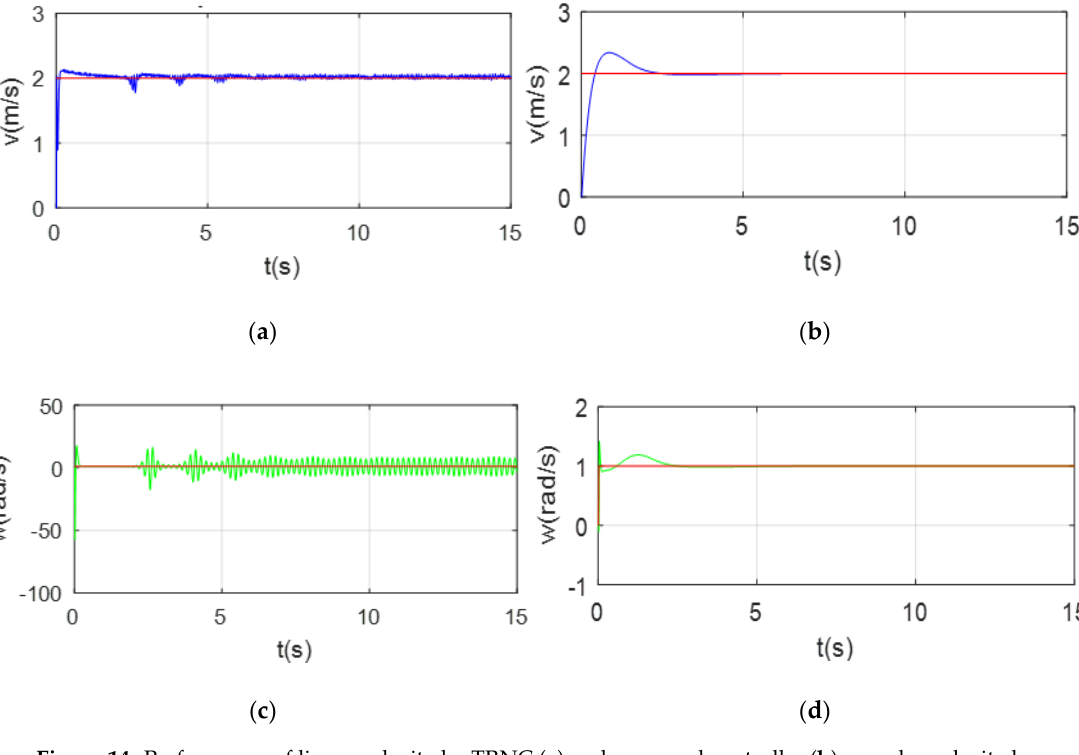
Figure 13. Tracking performance of circular trajectory by Typical robust nonlinear control (TRNC) ( a ) and proposed controller ( b ).